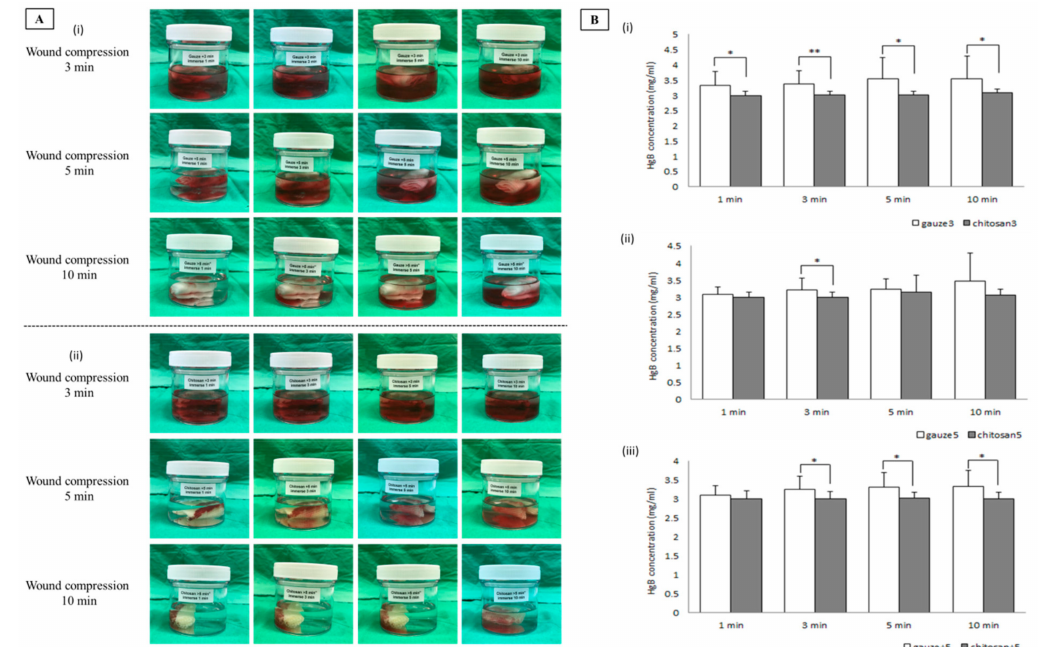
Figure 7. Hemoglobin absorption analysis. ( A ) Gauze and chitosan fiber dressings in contact with surgical wounds and normal saline solution. ( B ) Hemoglobin concentration in normal saline solution (1 min, 3 min, 5 min, and 10 min incubation), *p < 0.05, ** p <